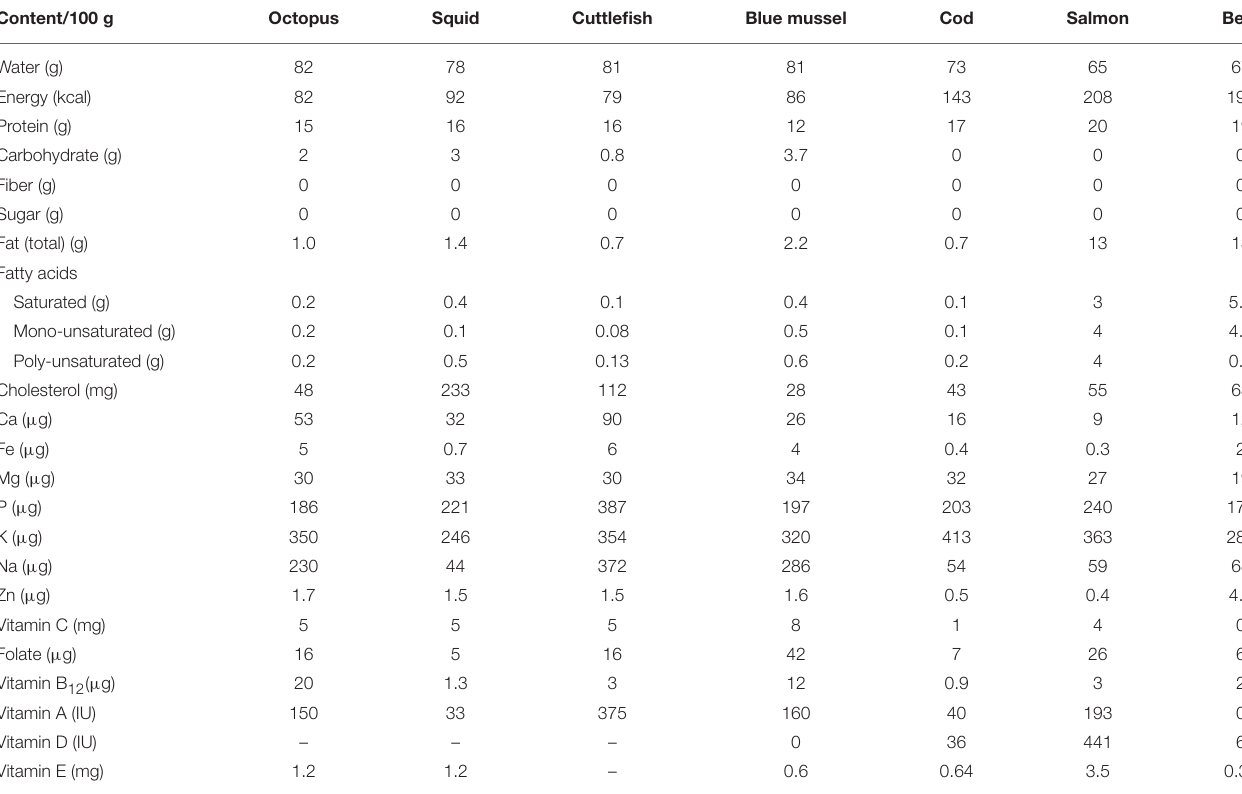
TABLE 1 | Contents of water, calories, macro and micro nutrients, fibers, and vitamins in three groups of cephalopods compared with the composition of blue mussel, salmon, and beef (grass-fed; ground, raw) (Ozogul et al., 2008; USDA, 2018). Content/100